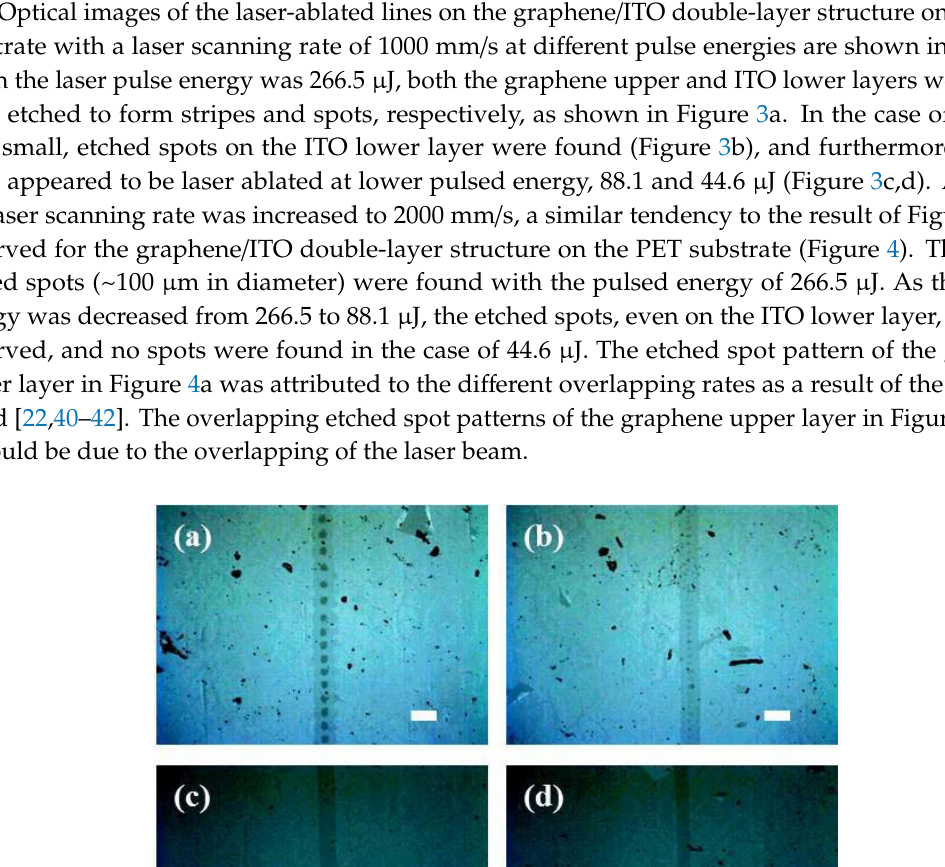
Figure 3. Optical microscopy images of the laser-patterned lines on the graphene / ITO double layer on a glass substrate produced with a scanning speed of 1000 mm / s at pulse energies of ( a ) 266.5, ( b ) 156.5, ( c ) 88.1, and ( d ) 44.6 µ J. White lines correspond to 100 µ